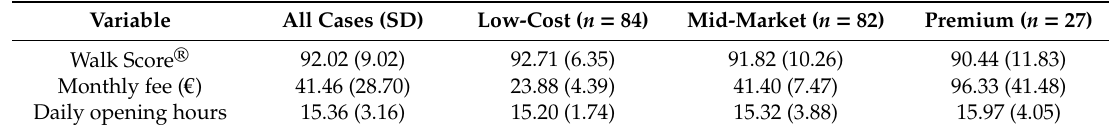
Table 1. Descriptive statistics.